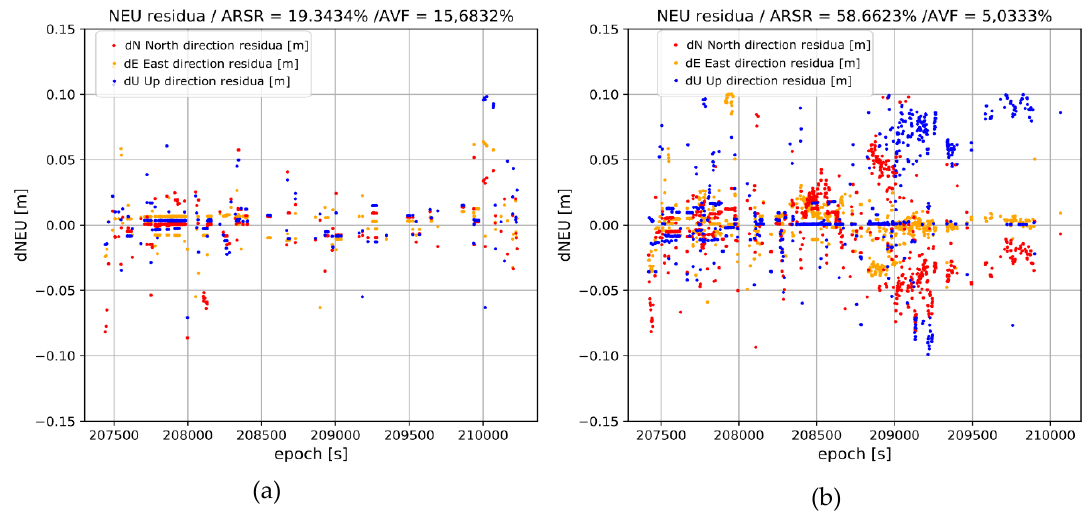
Figure 7. Rover position residua vs. the reference solution from processing the BROD baseline. ( a ) Without ionospheric corrections; ( b ) With CNES RT ionospheric corrections. Horizontal residua dE; dN are shown in orange and red, respectively; and blue depicts height component.